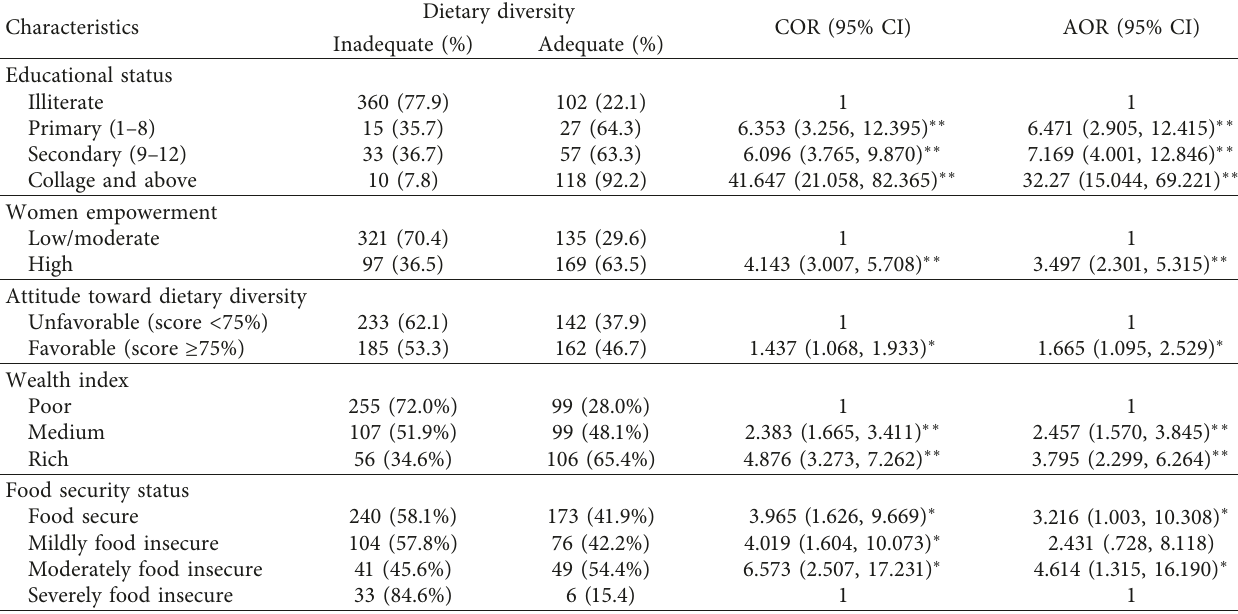
Table 5: Bivariate and multivariable logistic regression of factors associated with dietary diversity among pregnant women in the Gurage zone, southwest Ethiopia, 2021 ( n �